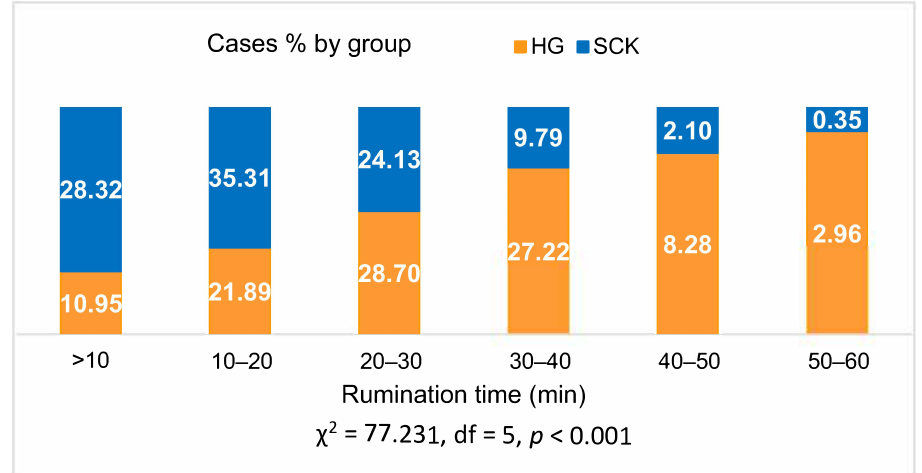
Figure 3. Relationship of rumination time (min) registered by RumiWatch noseband sensor readings between dairy cows of di ff erent health status in 2020 in Lithuania. SCK—Subclinical ketosis group, HG— healthy